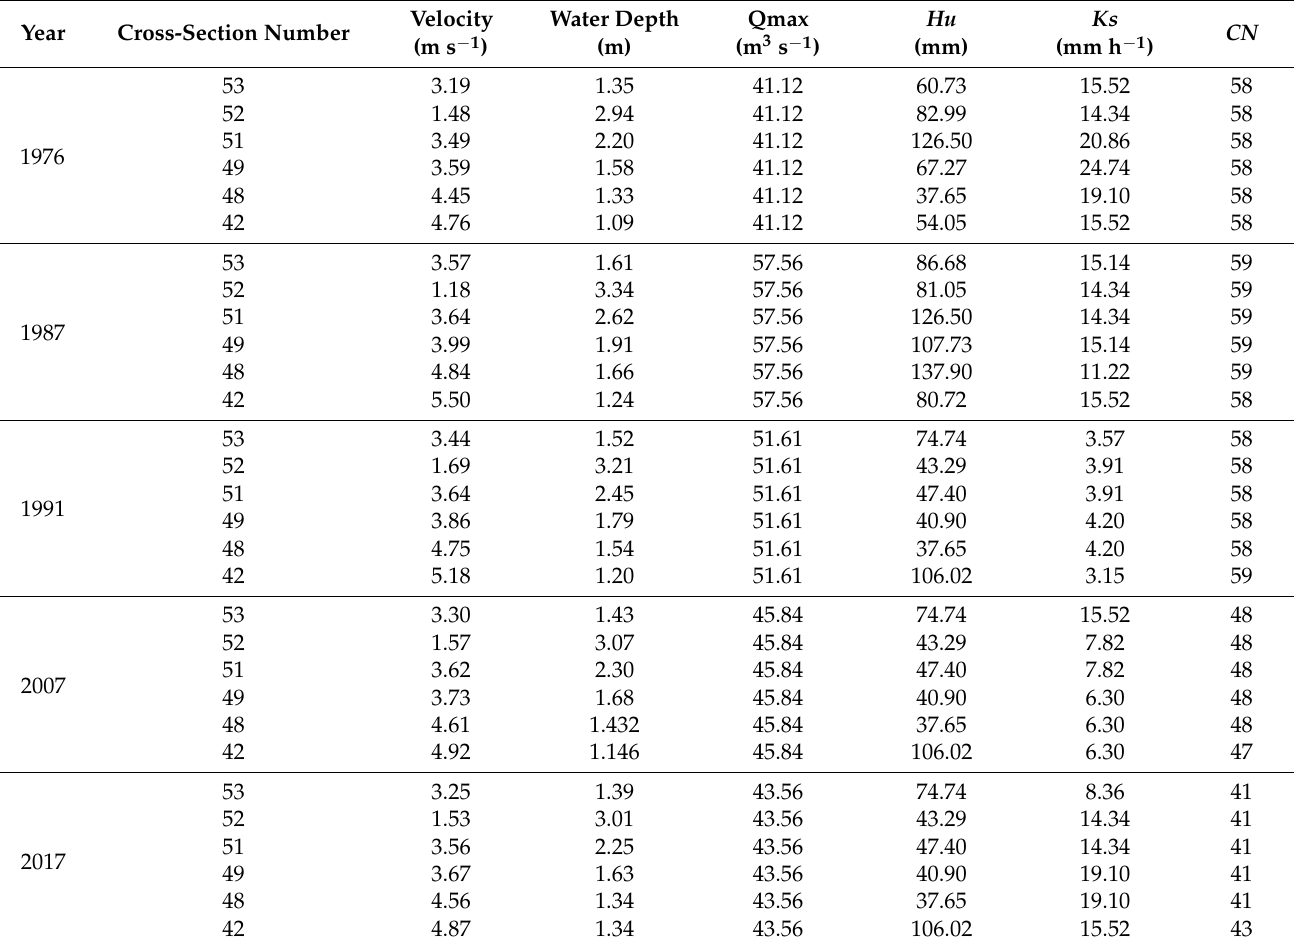
Table 2. Hydraulic characteristics of cross-sections per year.